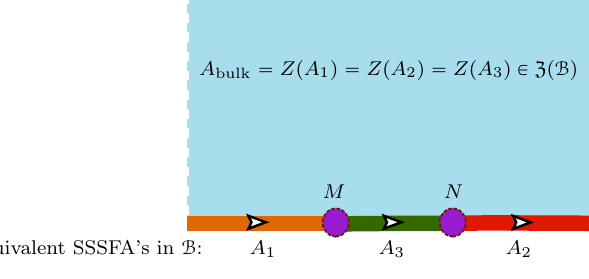
Figure 8 . This picture depicts a 1+1D world sheet, on which lives boundary CFT’s A 1 ; A 2 ; A 3 P B and a bulk CFT A bulk P Z p B q given by the full center of the boundary CFT’s. The domain wall M is an invertible A 1 - A 2 -bimodule and N is an invertible A 2 - A 3